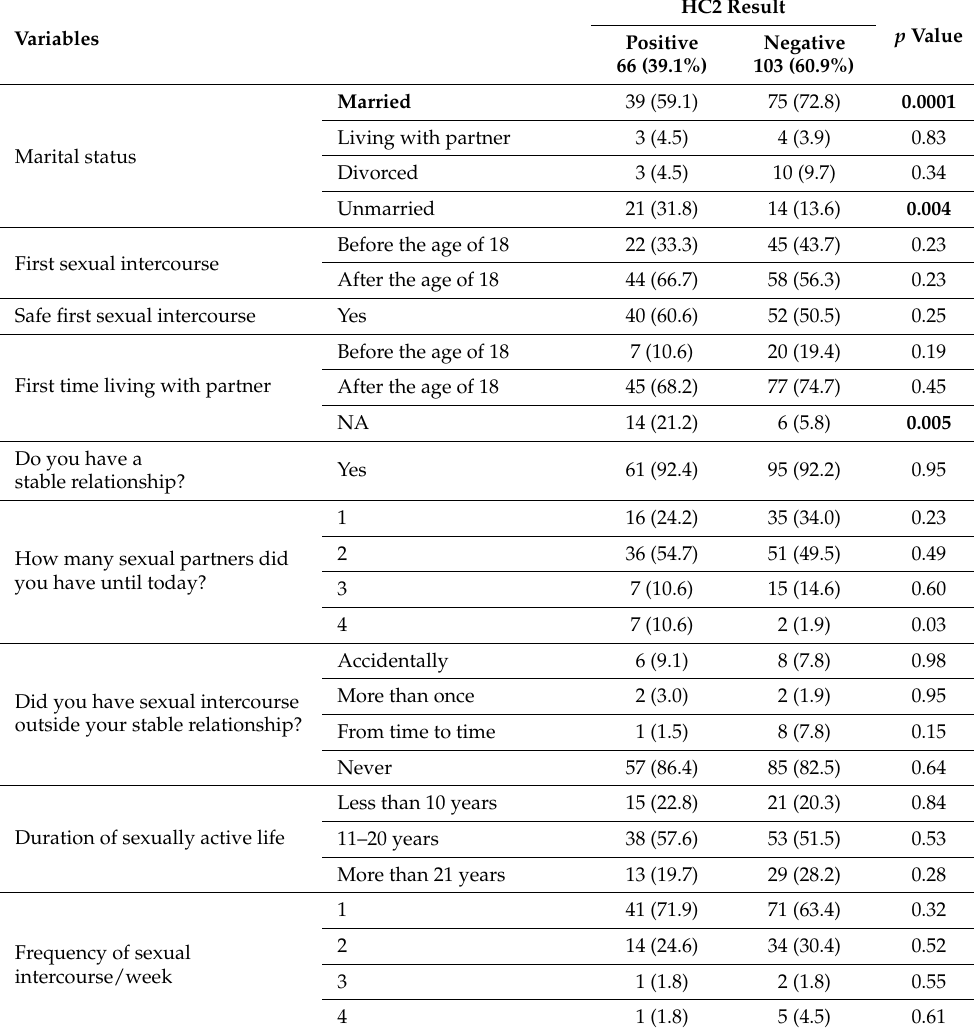
Table 2. Results of the HC2 testing in correlation with sexual behavior and characteristics of